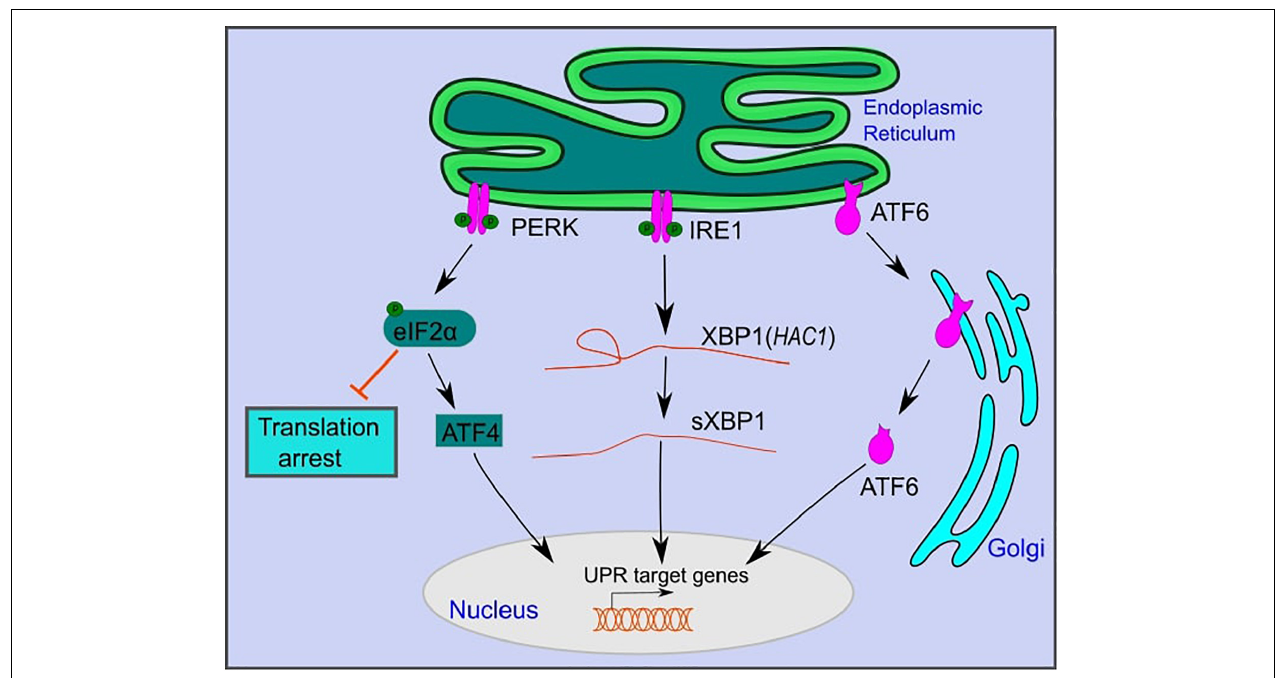
FIGURE 1 | The mammalian unfolded protein response pathway. The UPR is activated upon ER stress caused by the accumulation of unfolded proteins in the lumen of the ER. UPR activation is mediated by three branches: PKR-like endoplasmic reticulum kinase (PERK), inositol-requiring kinase 1 (IRE1), and activating transcription factor 6 (ATF6). PERK and IRE1 are activated by autophosphorylation. Active PERK phosphorylates eIF2 α , which inhibits overall protein translation, while selectively promoting the translation of activating transcription factor 4 (ATF4). Active IRE1 splices an intronic region from XBP1 mRNA ( HAC1 in yeast) to form sXBP1, which is translated into an active transcription factor. ATF6 is translocated to the Golgi, where it is cleaved and further translocated to the nucleus. ATF6, sXBP1, and ATF4 activate downstream signaling cascades that increase the expression of genes that function in restoring ER homeostasis or inducing cell death under persistent ER